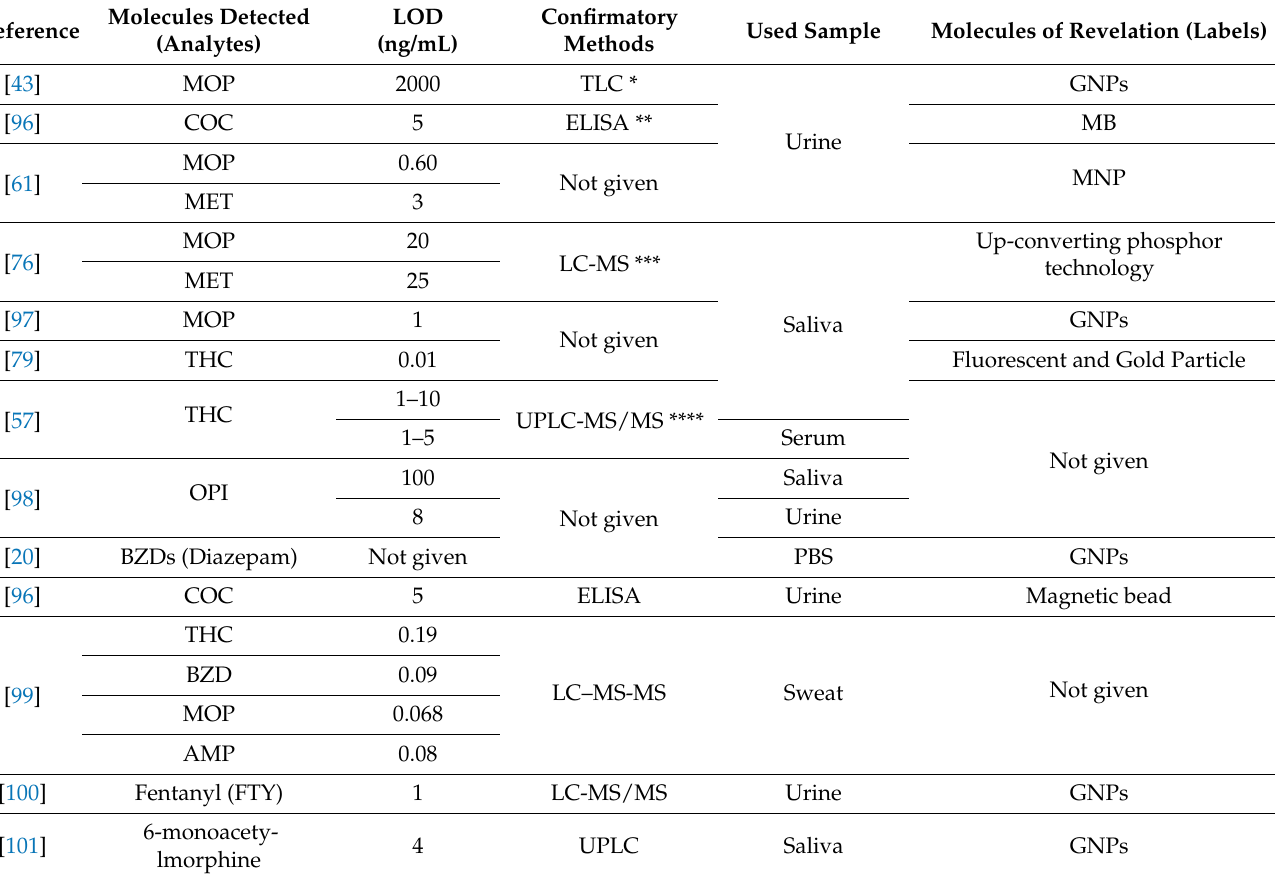
Table 2. LFIA methods for the determination of drugs of abuse (DOA) in biological samples that have been reported in the literature (from 2010 to